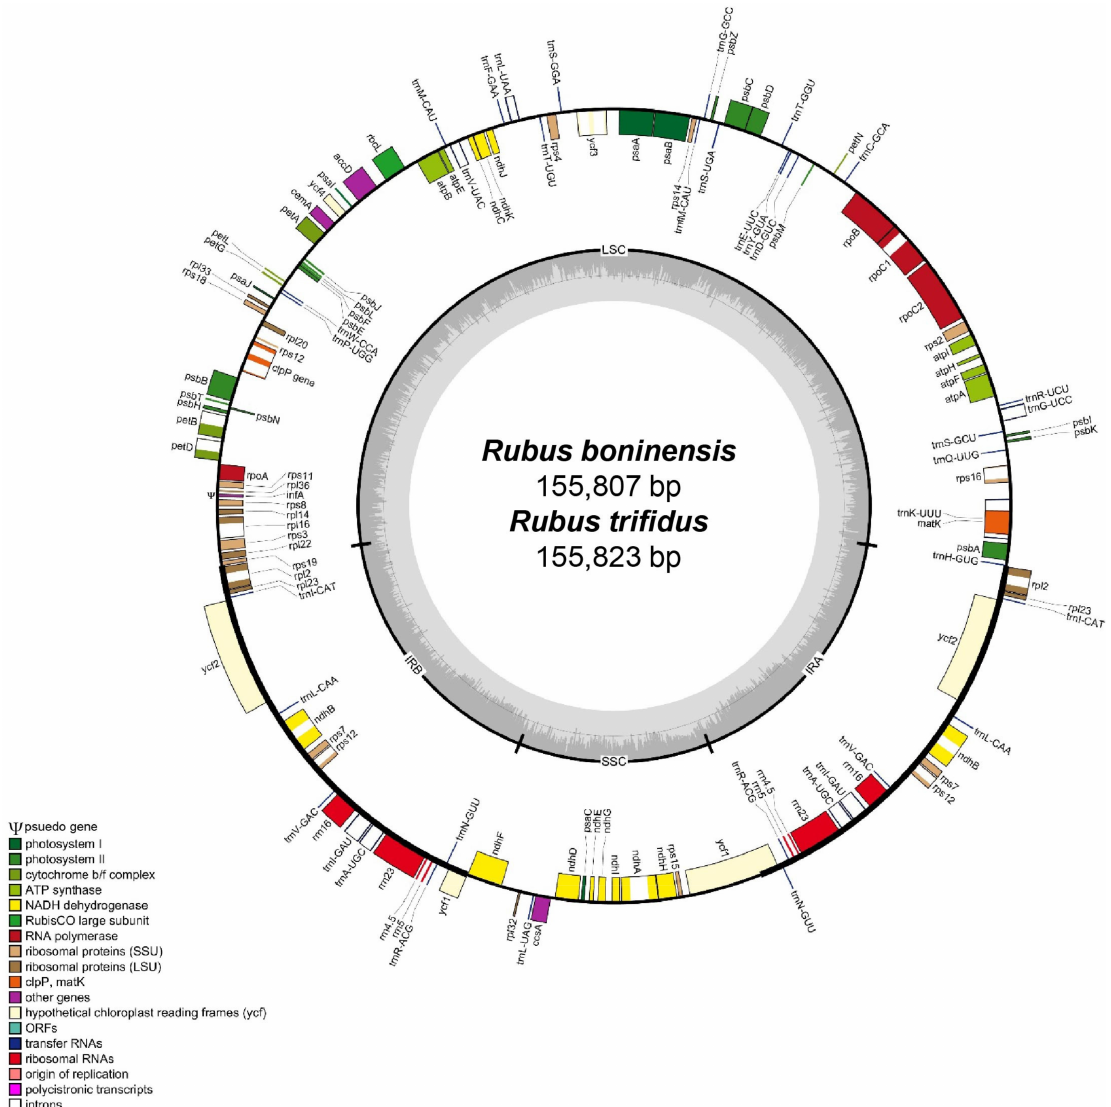
Figure 1. The complete plastome map of R. boninensis and R. trifidus . The genes located outside of the circle are transcribed clockwise, while those located inside are transcribed counterclockwise. The gray bar area in the inner circle denotes the guanine-cytosine (GC) content of the genome, whereas the lighter gray area indicates the adenosine-thymine (AT) content of the genome. Large single copy, small single copy, and inverted repeat are indicated with LSC, SSC, and IR, respectively. Ψ indicates